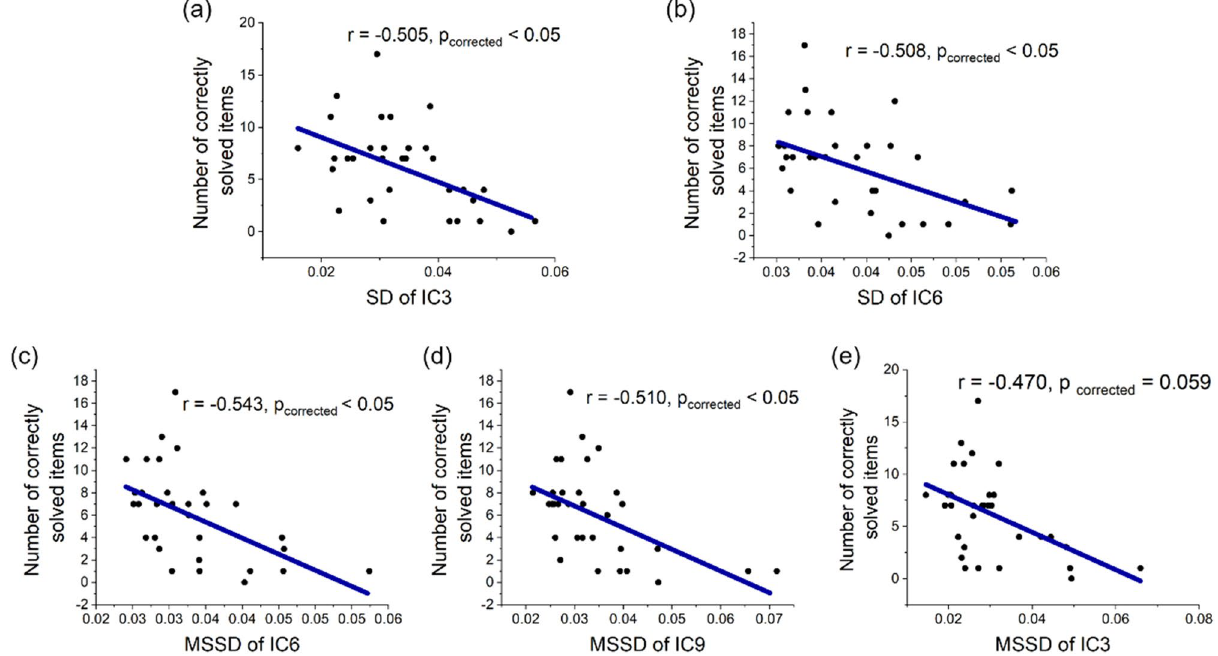
Figure 4. RAT performance was significantly (or, in the case of e, close to significantly) negatively correlated with brain variability of the parietal and motor network (i.e., IC3), parietal and frontal network (i.e., IC6), frontal and ACC network (i.e., IC9). Brain variability was calculated using SD in ( a , b ); brain variability was measured by MSSD in ( c – e